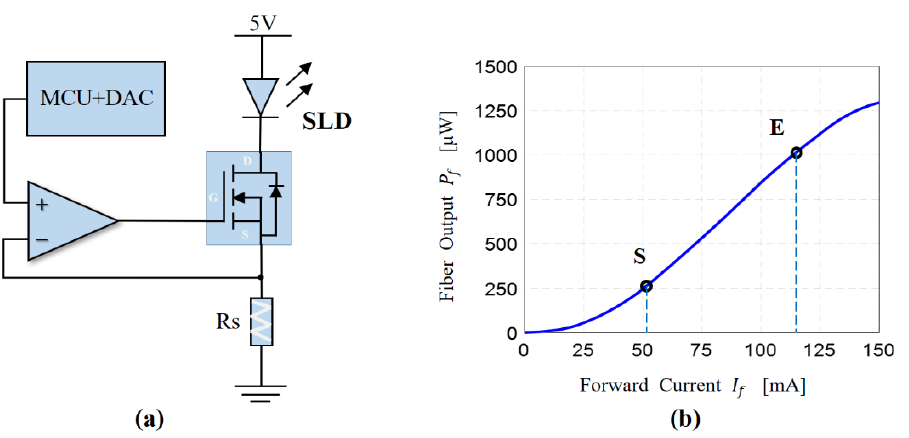
Figure 5. SLD power-modulation method. ( a ) Modulation circuit to control the drive current of the SLD light source. D, G and S is pin name of N-Channel MOSFET, G: gate, S: source, D: drain. ( b ) Relationship between SLD power and the drive current, from S to E can be approximated as a linear relationship.